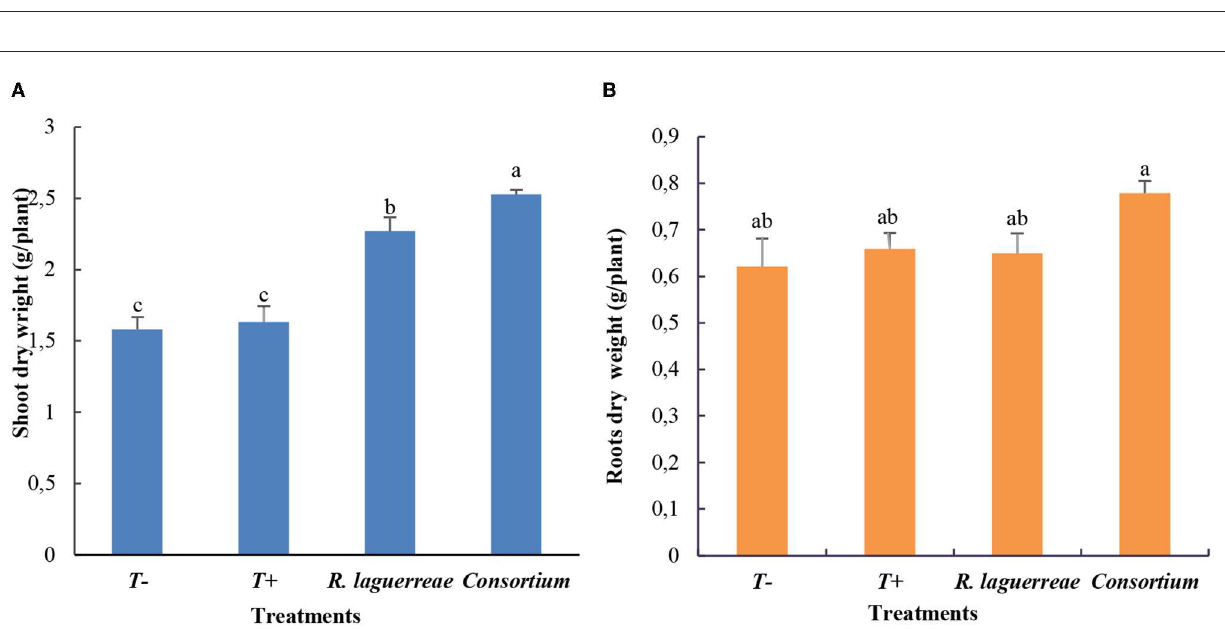
FIGURE10 Root (A) and shoot (B) biomasses of faba-bean in response to different treatments. Each value represents the mean ± of three independent replicates; different letters indicate that values by Tukey’s test are statistically different at a P -value of ≤ 0.05.